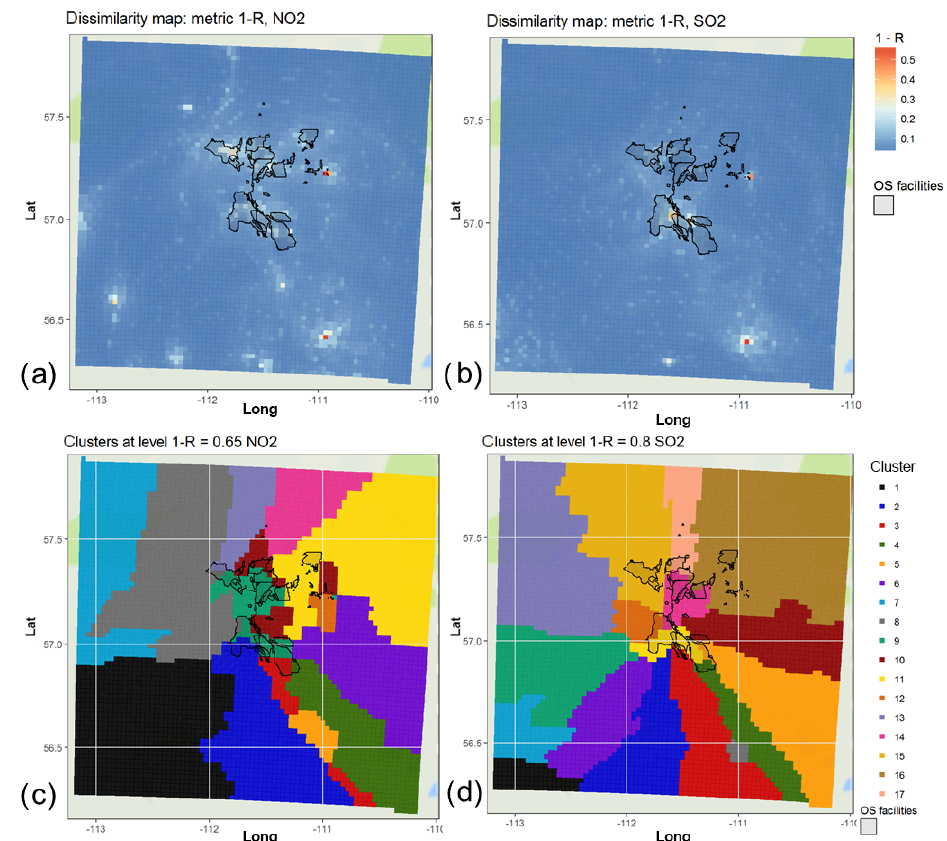
Figure 9. Dissimilarity maps based on 1 − R metric for (a) NO 2 and (c) SO 2 modelled hourly output at each GEM-MACH grid cell. Associativity analysis maps for modelled NO 2 and SO 2 based on these gridded output time series, appear in panels (b) and (d) , respectively. The latter maps were generated using a (1 − R ) dissimilarity level of (b) 0.65 and (d) 0.8. All maps show the areas enclosing the property boundaries of the main mining facilities operating in the Athabasca oil sands region (black contours enclosing transparent light grey